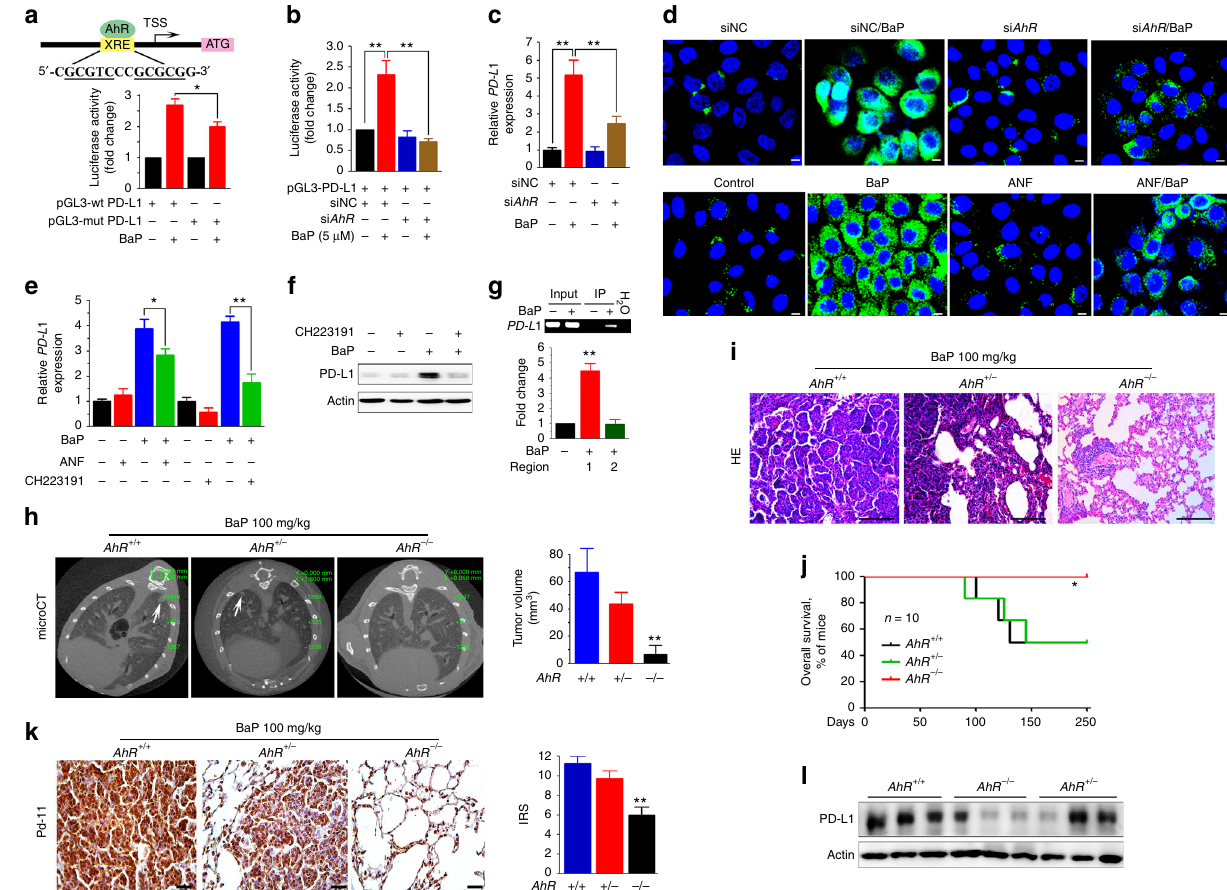
Fig. 3 AhR mediates BaP-induced PD-L1 expression. a The AhR binding site of PD-L1 promoter (upper panel). TSS, transcription start site. The H460 cells were transfected with the wild-type (wt) or mutant (mut; deletion of 5 ’ -GCGTC-3 ’ fragment in the XRE-like sequence) PD-L1 promoter-luciferase reporter construct, treated with BaP for 48 h, and assessed by the luciferase assays (lower panel). Student ’ s t test, *, P < 0.05; **, P < 0.01. Error bars, sd. b Luciferase assays were performed in H460 cells transfected with wt PD-L1 promoter-luciferase reporter construct and siRNAs in the absence or presence of BaP. c , d The expression of PD-L1 at mRNA (detected by real-time PCR, c) and protein (detected by immuno fl uorescence assay, ( d ) levels in AhR silencing 16HBE cells upon BaP. Scale bar = 20 μ m. e The expression of PD-L1 at mRNA (detected by real-time PCR) level in 16HBE cells co-incubated with BaP, with or without ANF/CH223191 treatment. f Western blot analysis of PD-L1 in 16HBE cells treated with CH223191 (10 μ M) and/or BaP (5 μ M) for 48h. g Chromatin immunoprecipitation (ChIP) assay was performed using AhR-precipitated DNA samples of 16HBE cells (treated with or without BaP) and primers for PD-L1 . The expression of PD-L1 was evaluated by RT-PCR (upper panel) and real-time RT-PCR (lower panel). h AhR de fi cient mice were treated with BaP, scanned by Micro-CT, and the tumor volume was calculated. i HE staining of lung tissue sections from AhR wild-type (wt) or knockout mice. Scale bar = 500 μ m. j Lifespan of the mice. Log-rank test, * P < 0.05; ** P < 0.01. k Immunohistochemistry assays and the corresponding